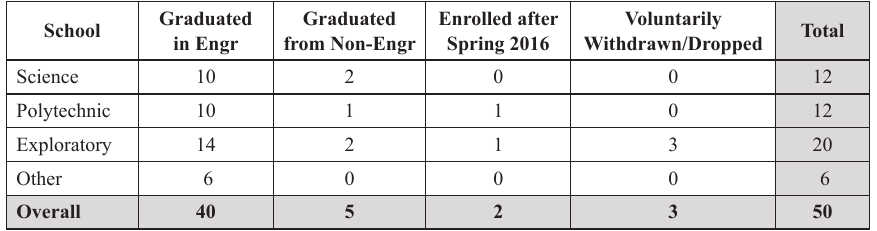
Table 4. Six-year graduation status of Purdue underrepresented minority students with